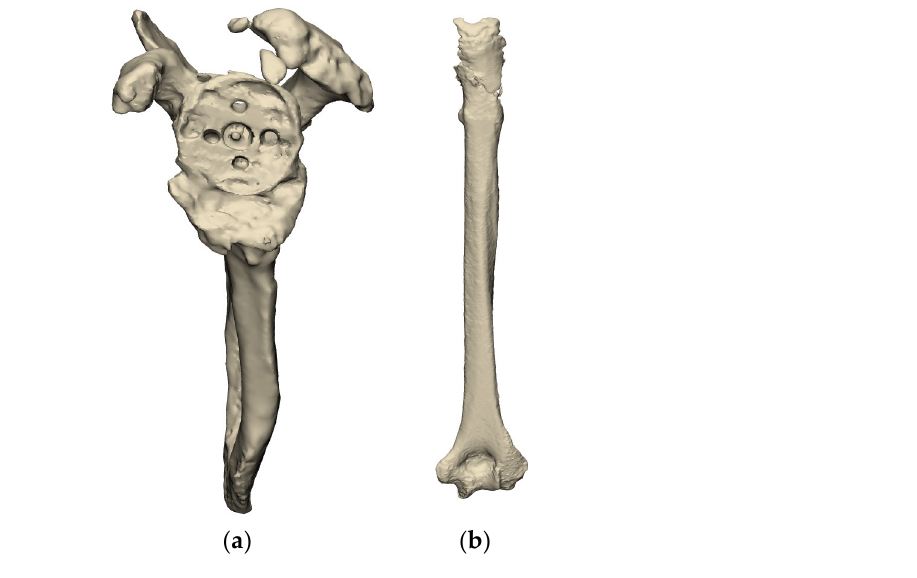
Figure 2. 3D reconstructions of the scapula ( a ) and humerus ( b ) after subtraction of the primary implants in situ (images from Reflect COMPLEX TM (Akunah, Brisbane, Australia)).